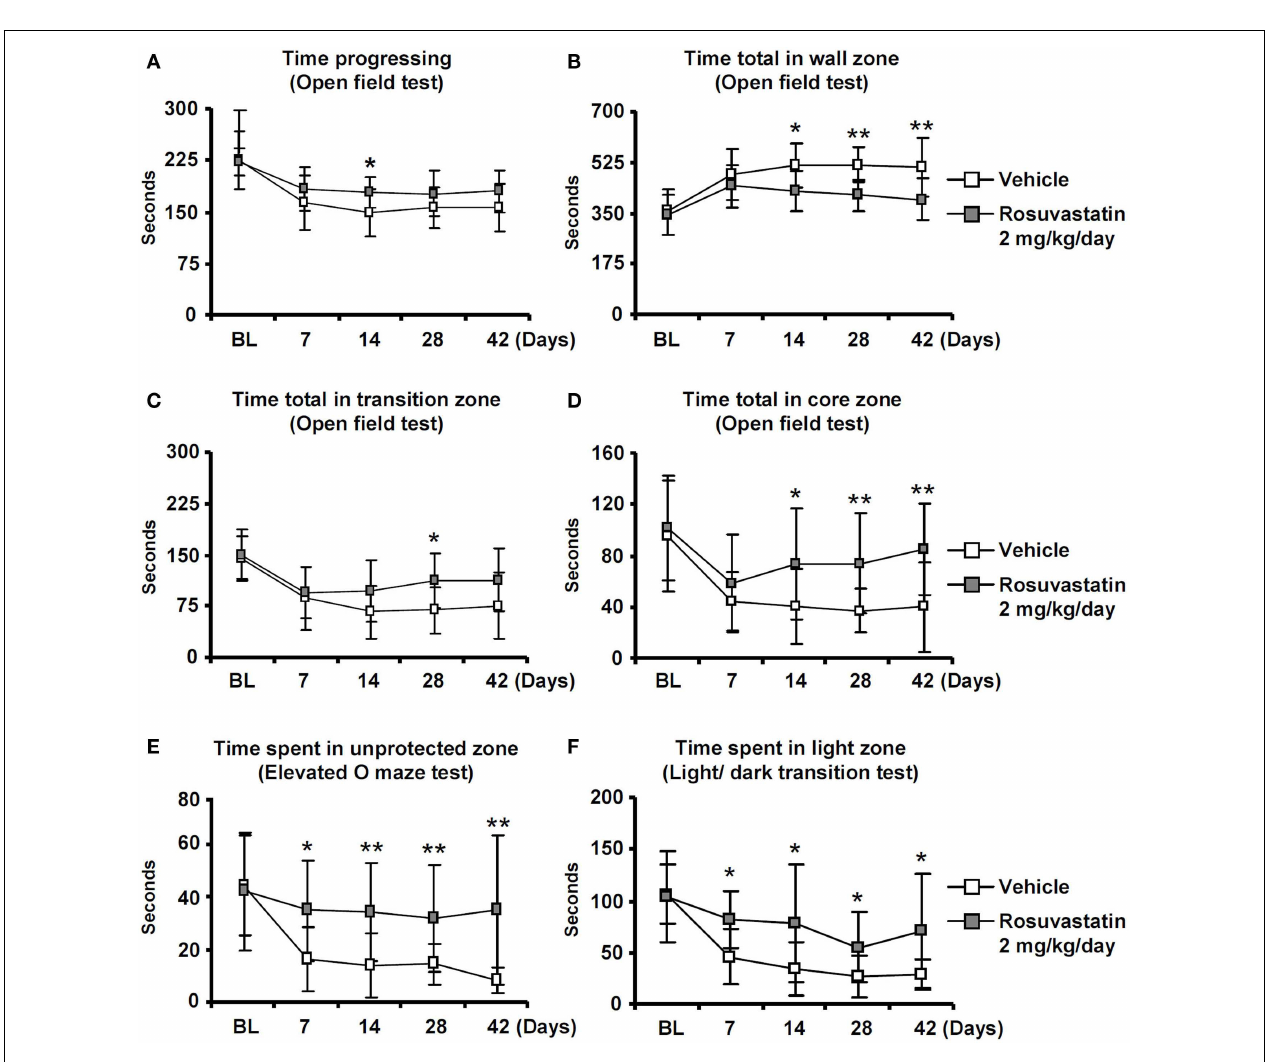
not differ between groups (A) , exploration activities of ischemic mice in the transition zone (C) , and core zone (D) of the open field are increased by rosuvastatin. Furthermore, note that the time spent in the unprotected zone of the elevated O maze (E) and the time spent in the light zone of the light/dark test (F) are increased by rosuvastatin, indicating that post-stroke anxiety is attenuated by HMG-CoA reductase inhibition BL, baseline. Data are mean values ± SD ( n = 20 animals/group). ** p < 0.01/* p < 0.05 compared with ischemic